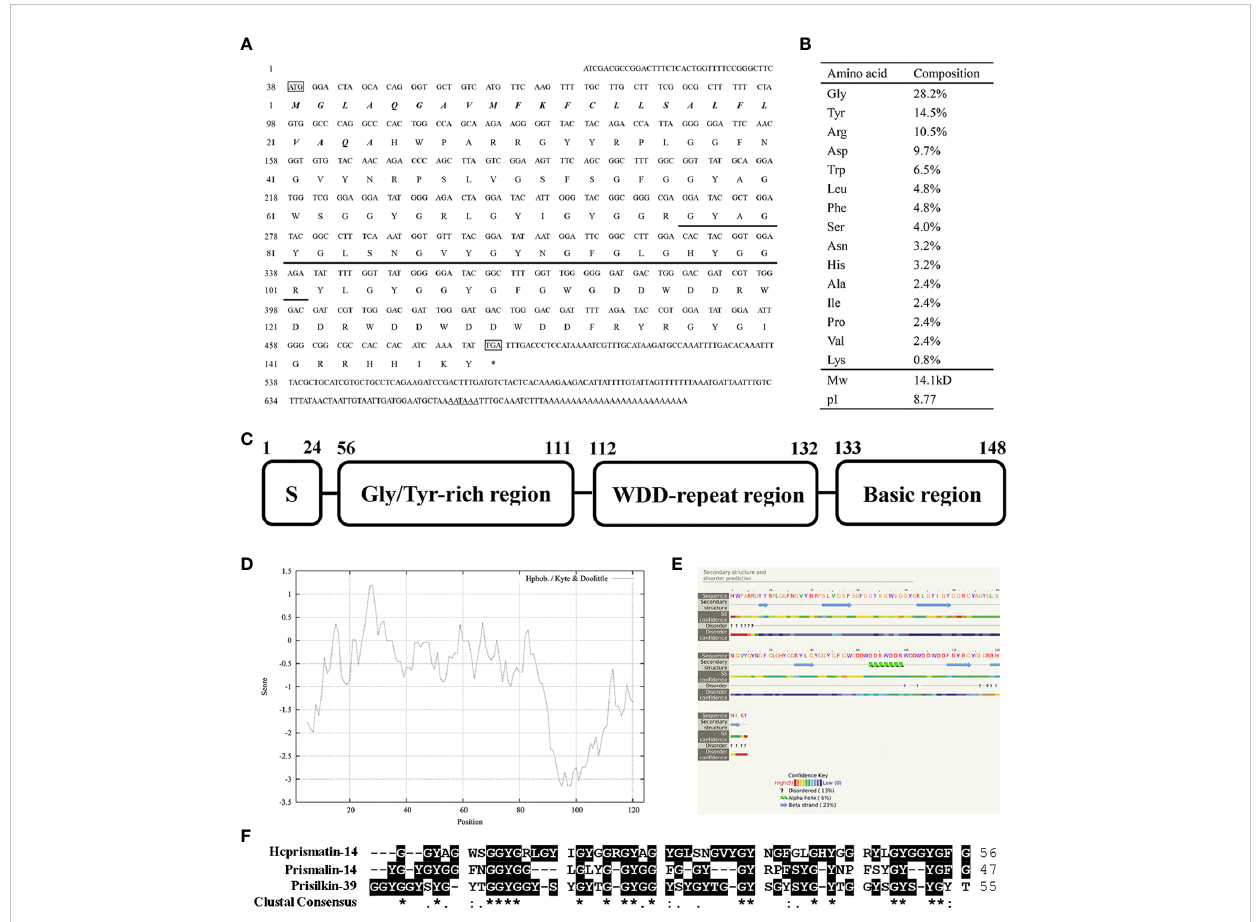
FIGURE 2 Sequence analysis of Hcprismatin-14. (A) The full-length cDNA and putative amino acid sequence of Hcprismatin-14. The initiation codon ATG and termination codon TGA are boxed. The signal peptide is bold italic. The amino acid sequence detected by liquid chromatography tandem mass spectrometry is underlined. The putative polyadenylation signal AATAAA is underlined by a double solid line; (B) Amino acid composition of Hcprismatin-14; (C) The modular structure of Hcprismatin-14. S, signal peptide. (D) The hydrophobicity analysis by ProtScale; (E) The secondary structure prediction performed by Phyre 2 . The regions adopting putative a -helix and b -sheet conformations are represented as green spiral and blue arrow, respectively. (F) Alignment of GY rich region of Hcprismatin-14 with repeats 3-7 of Prisilkin-39 (residues 83-138) and GY rich region of Prismalin-14 (residues